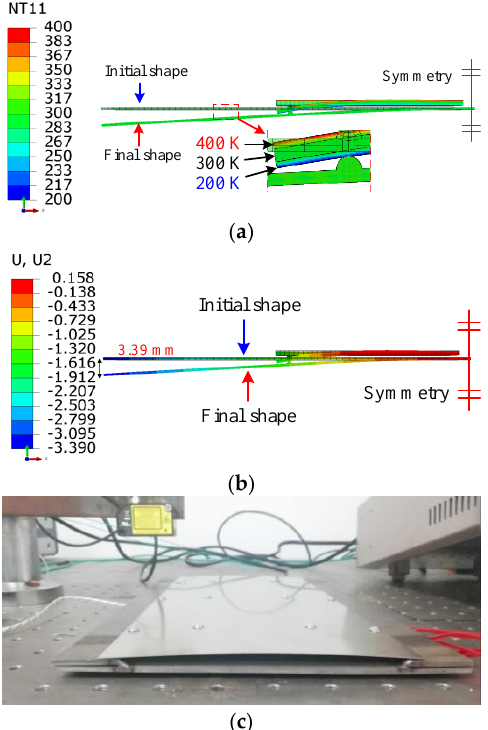
Figure 18. The deformation driven by SMA plate under the low-temperature conditions: ( a ) temperature distribution; ( b ) displacement in the Y -direction; ( c ) experimental measurement of deformation.